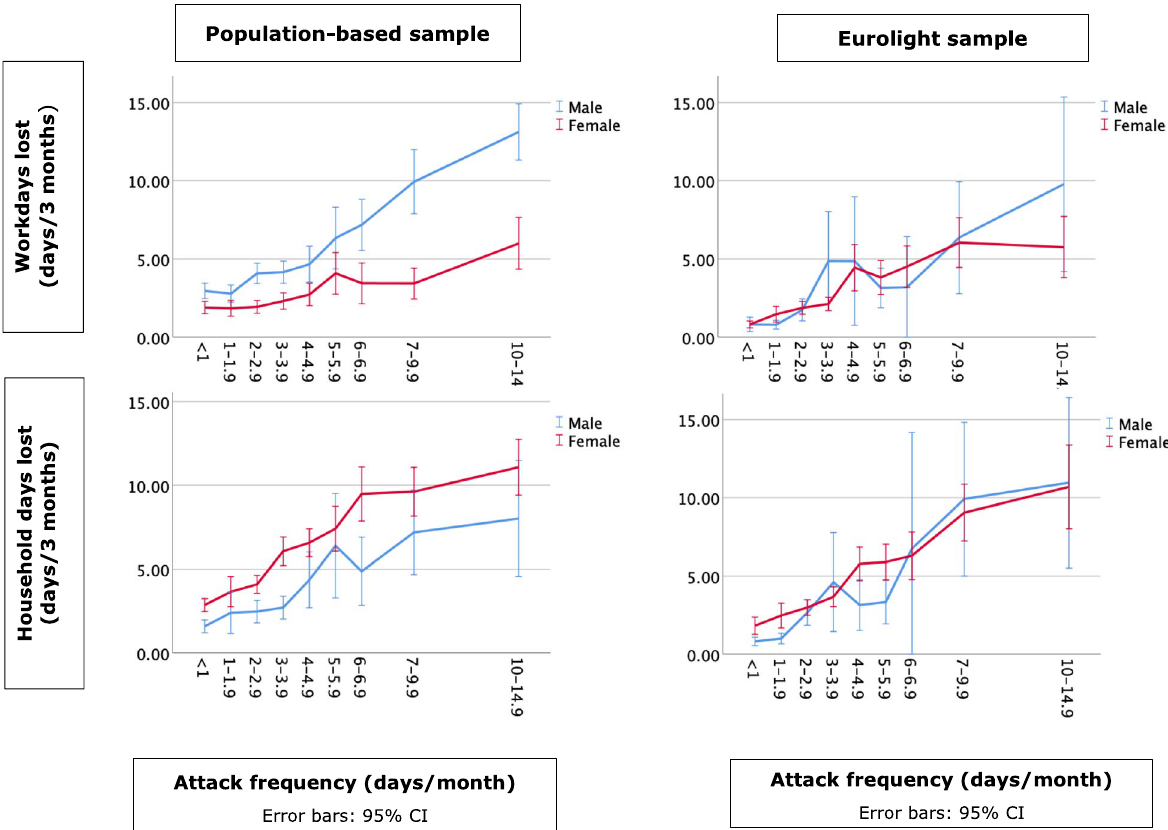
Fig. 1 Relationship between lost productivity (work days and household days) and attack frequency by sample and